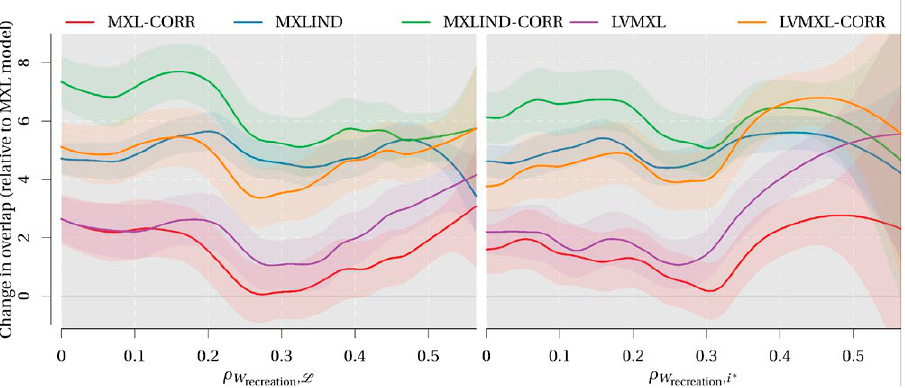
Figure 3. Percentage point difference in overlap of MWTP distributions relative to the true MWTP dis- tribution for